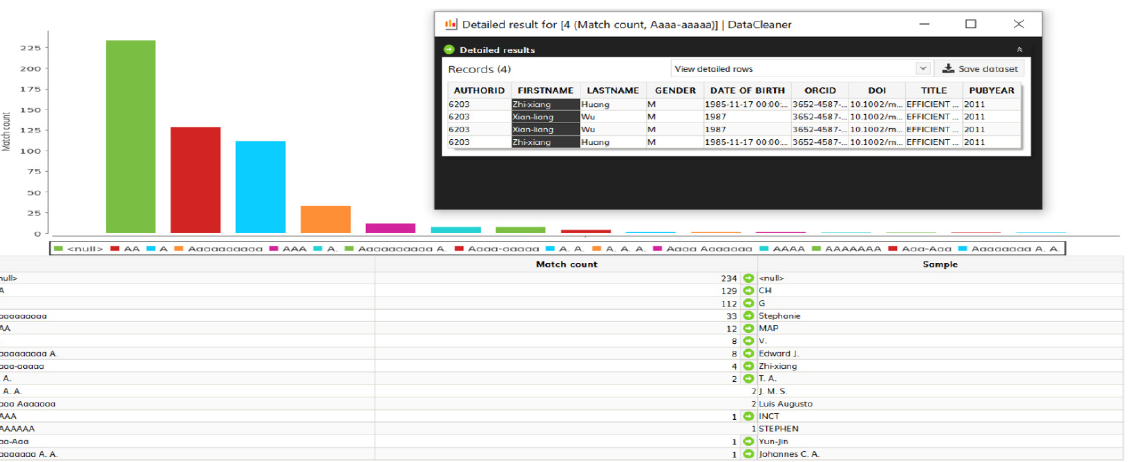
Figure 8. Duplicate detection of more than hundreds of thousands of publication data with Data- Cleaner.